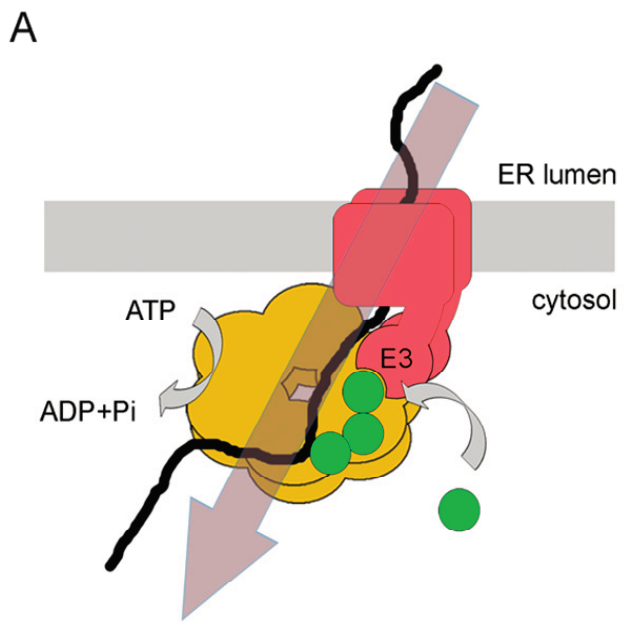
Figure 3. Models for PUC processing as a mechanism for protein